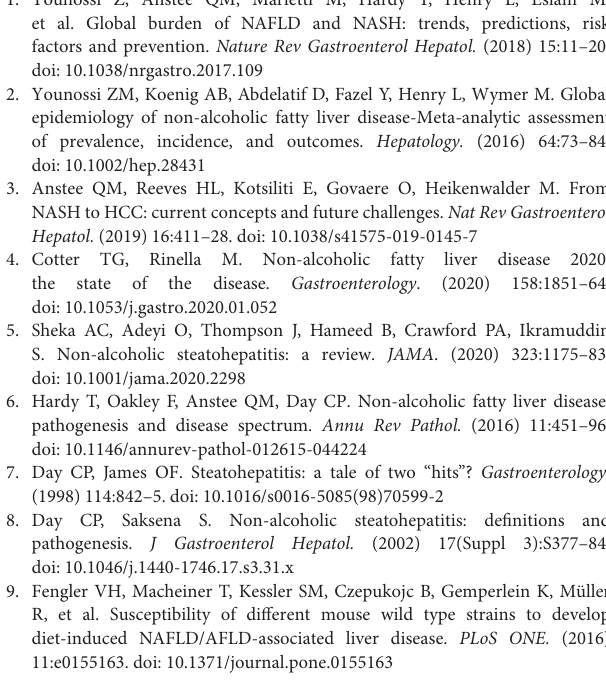
Supplementary Table 1 | Mineral Composition of Aquamin ® Soluble. Supplementary Table 2 | Common and unique upregulated proteins (at 2-fold change threshold). Supplementary Table 3 | Common and unique downregulated proteins (at 2-fold change threshold). Supplementary Table 4 | Comprehensive list of upregulated (and significantly altered) proteins with Aquamin ® in high-fat mice. Supplementary Table 5 | Top pathways associated with significantly upregulated proteins (shown in Supplementary Table 4 ) altered with Aquamin ® .